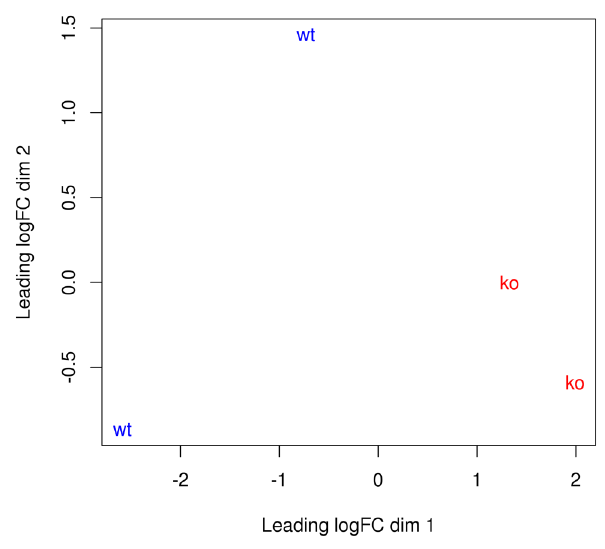
Figure 12. MDS plot with two dimensions for all libraries in the CBP data set. Libraries are labelled and coloured according to the genotype. A larger top set of windows was used to improve the visualization of the genome-wide differences between the WT